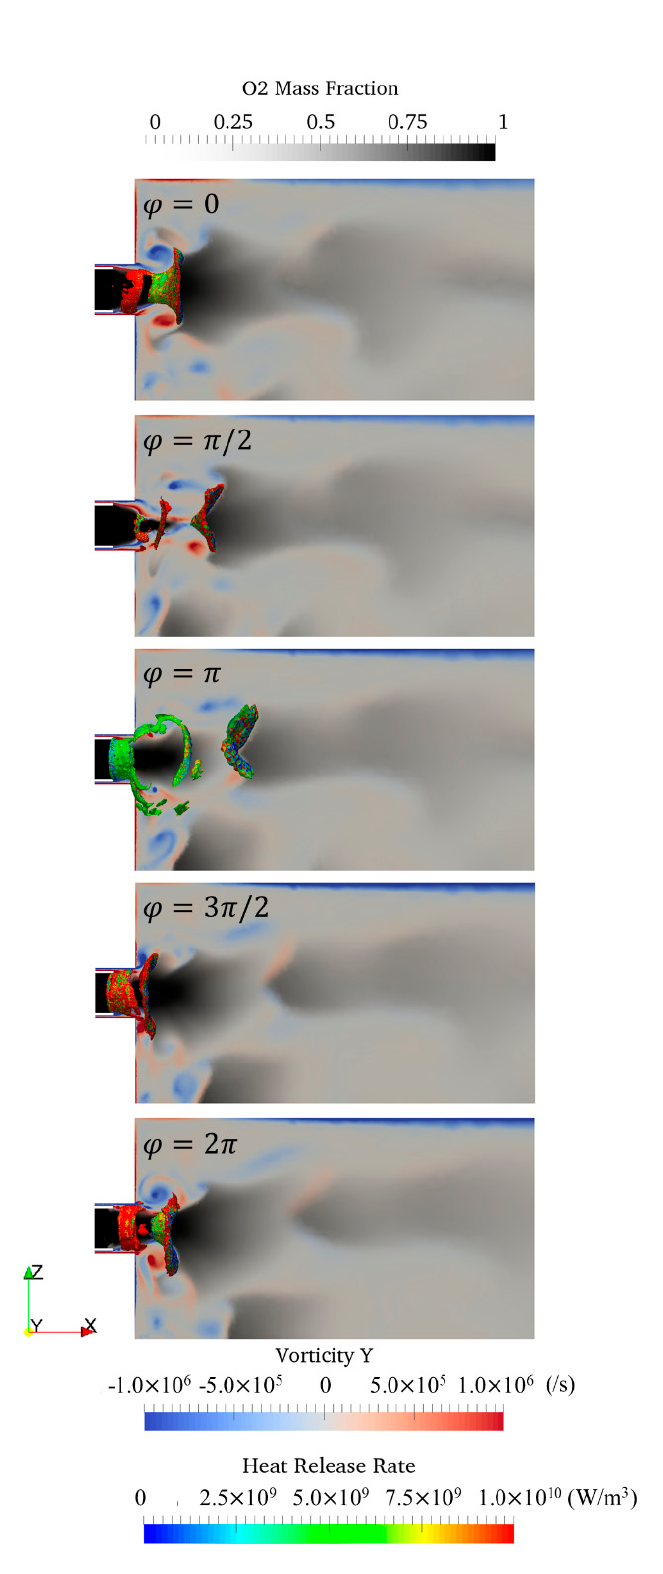
Figure 14. Contour plots of the oxygen mass fraction, y -vorticity with the iso-surface of the heat release rate according to the phase change for the analysis plane of injector B during one period of the cycles.